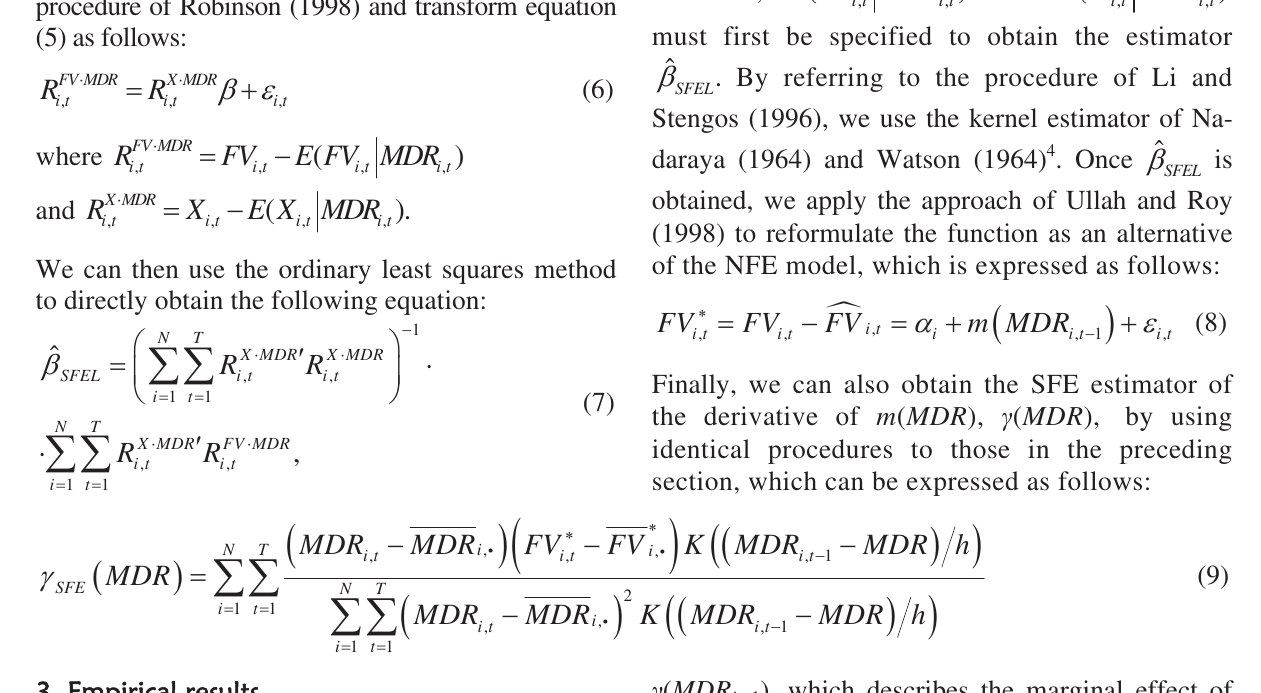
), (cid:534) ( MDR ), i , t -1 i , t -1